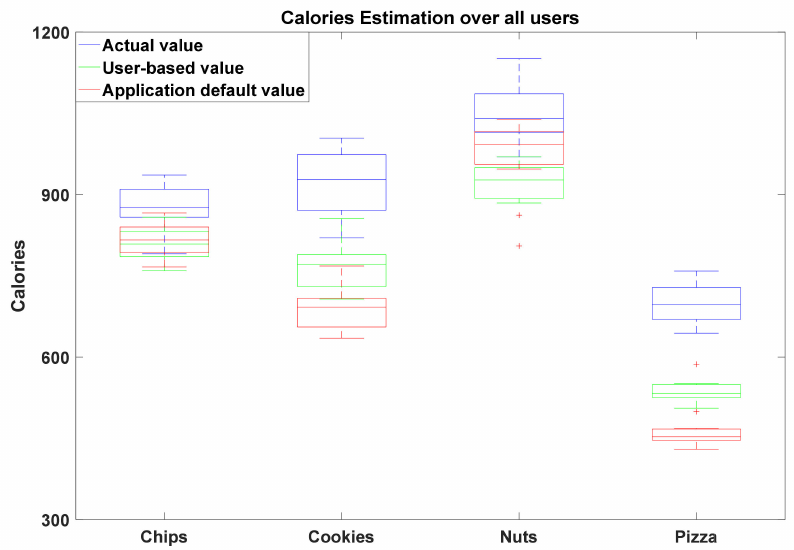
Figure 10. Calorie estimation methods and comparison with actual caloric